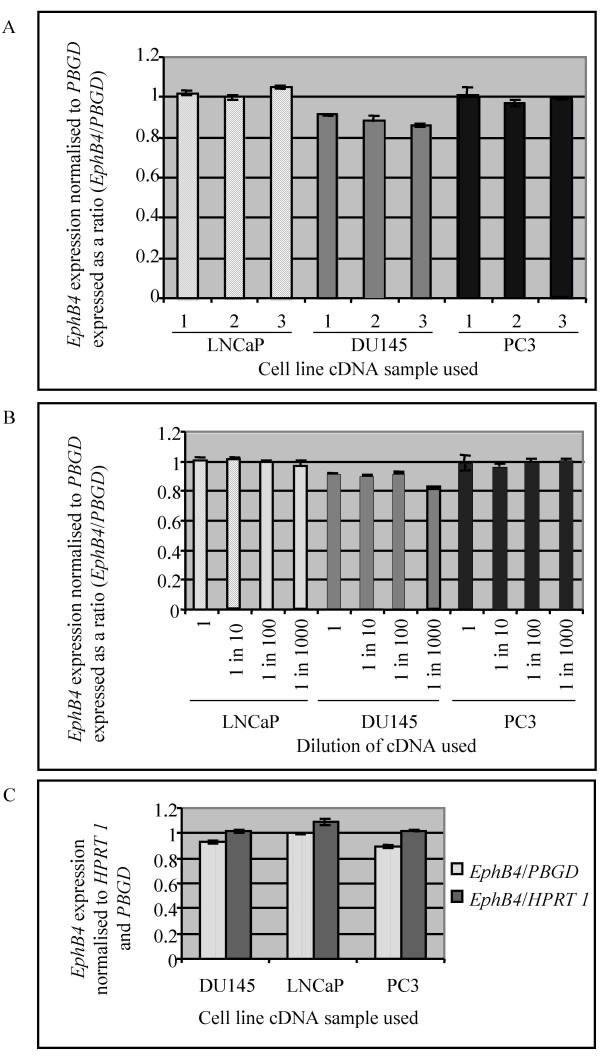
Normalisation of EphB4 expression to housekeeping genes PBGD and HPRT1. EphB4 expression normalised to PBGD in prostate cancer cell lines LNCaP, DU145 and PC3. (A) Triplicate amplifications of EphB4 and PBGD in three samples for each cell line were analysed to determine the relative levels of EphB4 expression using the BioRad iCycler. All EphB4/PBGD ratios were close to 1 indicating that there are comparable amounts of both templates in each RNA samples. (B) Dilutions of a single RNA sample for each cell line were also amplified in triplicate with both gene primer sets to confirm that the ratio was consistent regardless of starting template concentration. (C) Triplicate amplifications of EphB4, PBGD and HPRT1 in three samples for each cell line using the Corbett Rotorgene confirmed the previous result for EphB4/PBGD and showed a similar result when EphB4 expression was normalised to a second housekeeping gene.